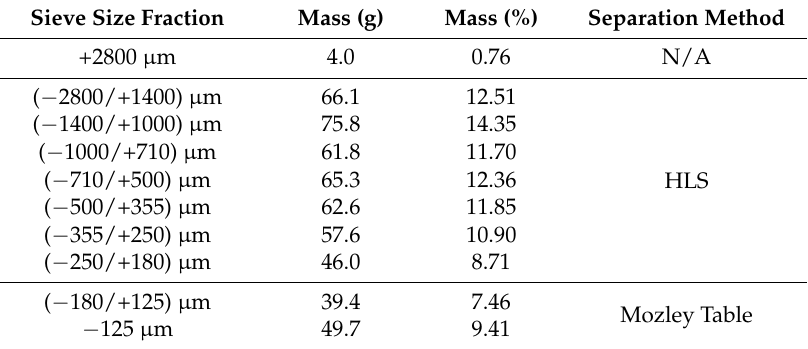
Table 1. Size fractions acquired through sieving of a representative sample from Penouta. Sieve Size Fraction Mass (g) Mass (%) Separation